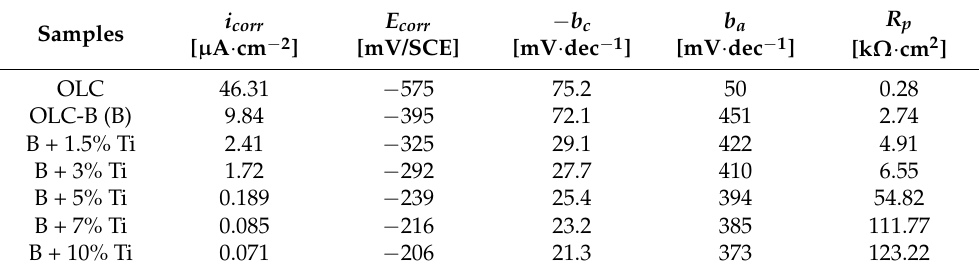
Table 2. Polarization parameters for samples tested in H 2 SO 4 0.5 M (pH = 0.3) + 2 ppm F −